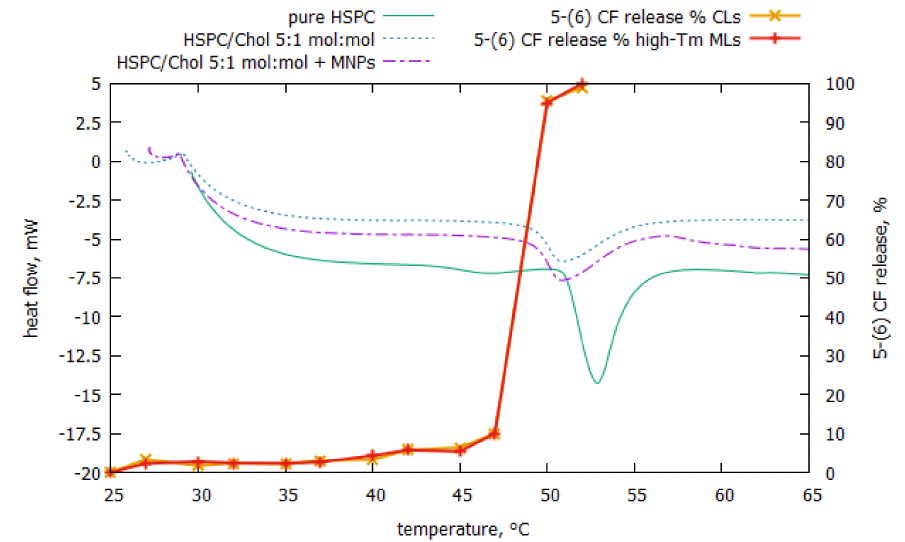
Figure 3. 5-(6) CF cumulative release from high-Tm MLs (red points-lines) and CLs (orange points-line) as a function of temperature from 25 to 52 ◦ C and DSC scanning profile of the melting process of HSPC/Chol 5:1 mol:mol mixture with or without MNP S .